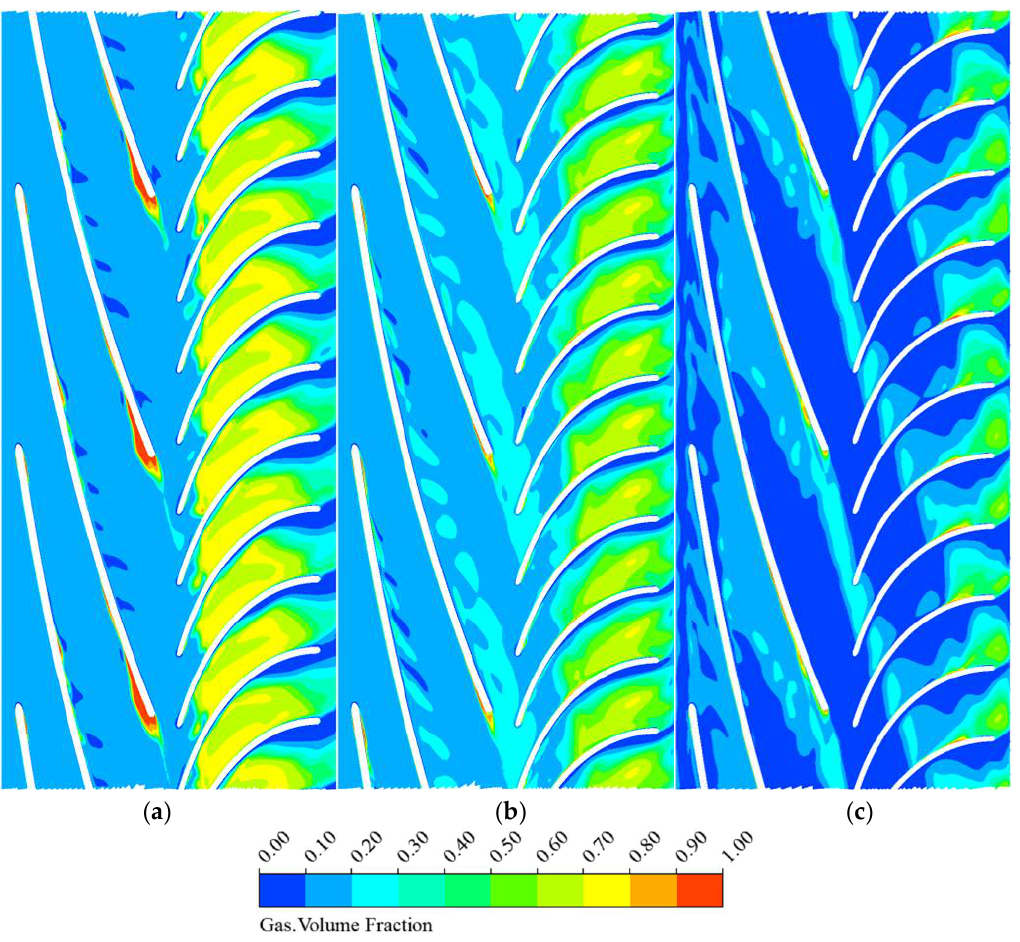
Figure 10. GVF distribution in impeller and diffuser of different spans under GVF = 15%. ( a ) span = 0.1; ( b ) span = 0.5; ( c ) span = 0.9.